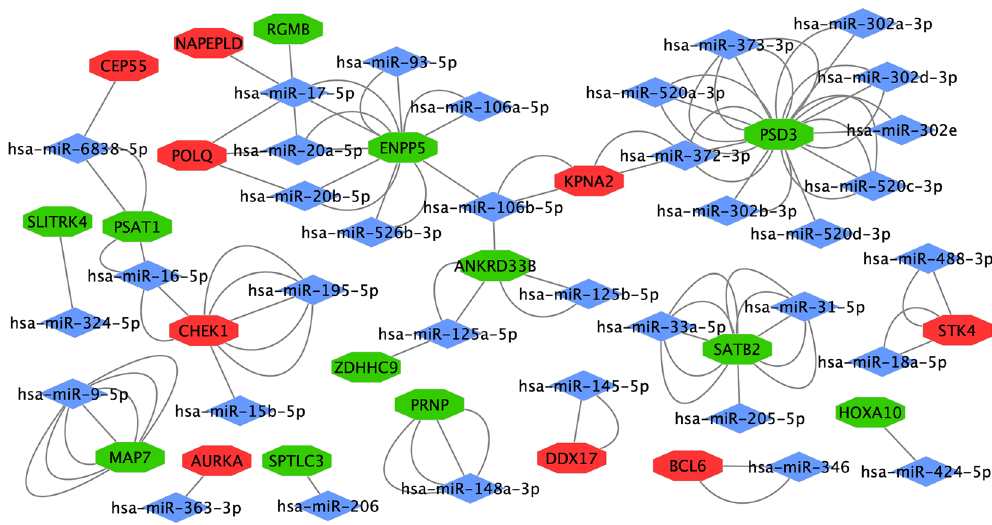
Figure 6. Regulatory relationships between human genes and predicted miRNA analyses as determined using miRWalk 3.0. Red indicates up-regulated genes, green down-regulated genes and blue indicates predicted